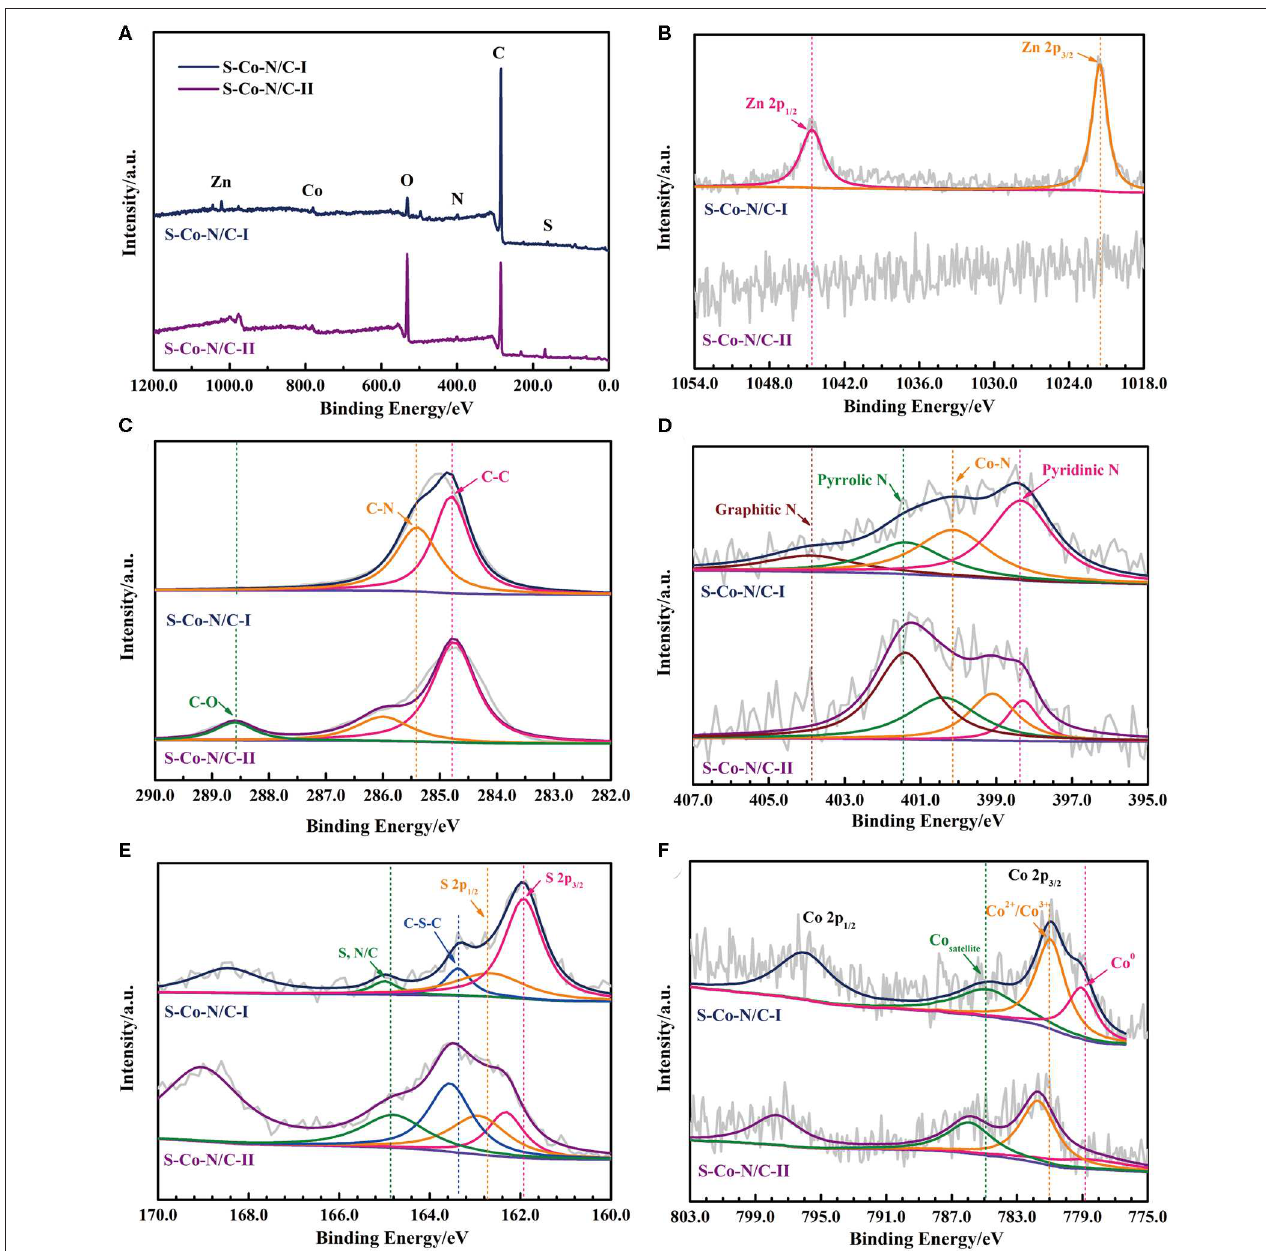
FIGURE 3 | (A) XPS survey scan, High resolution-XPS spectrum of (B) Zn 2p, (C) C 1s, (D) N 1s, (E) S 2p, and (F) Co 2p in the S-Co-N/C materials.